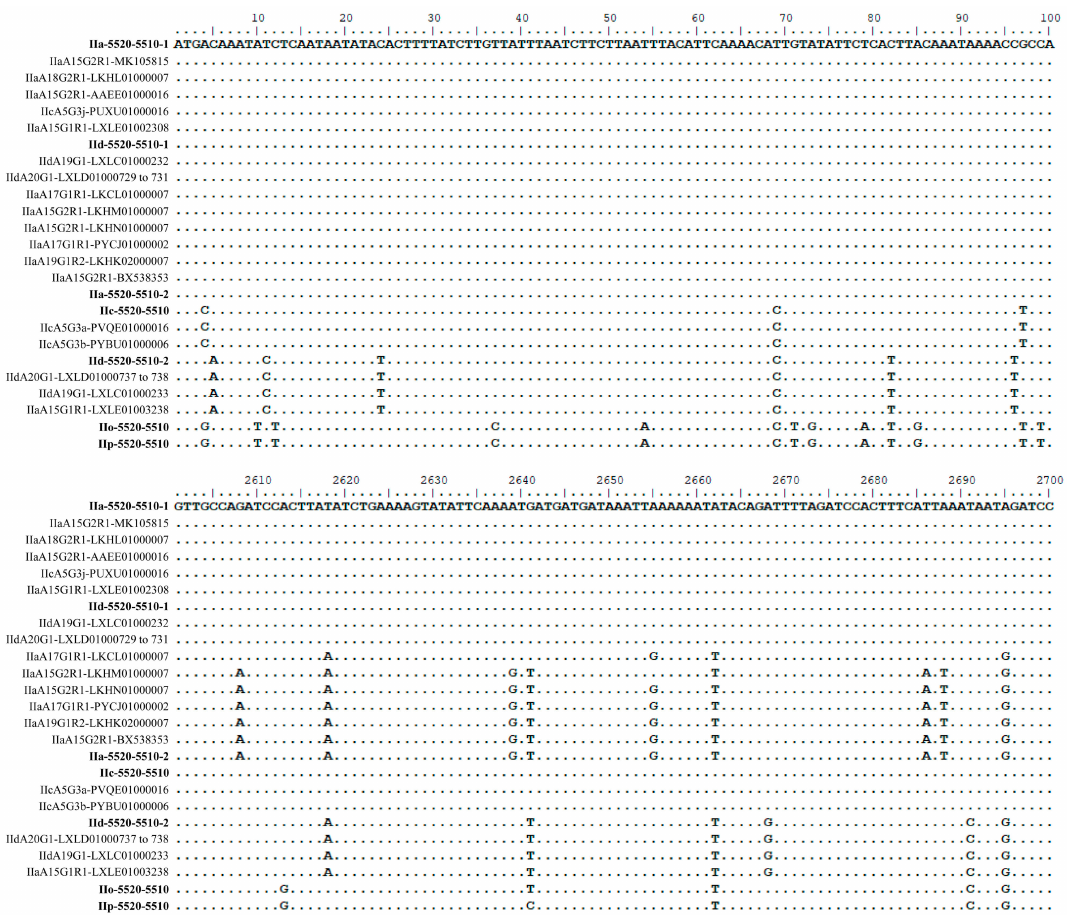
Figure 3. Alignment of unique nucleotide sequences of the cgd6_5520-5510 gene obtained in this study together with 18 other cgd6_5520-5510 sequences. Seven representative sequences of the cgd6_5520-5510 gene obtained in this study are shown in bold. The remaining 18 sequences were downloaded from the GenBank database (Table 3). The nucleotides identical to the reference sequence (the first line of the alignment) are shown as dots. Some of the sequences, which are identical in the first 2607 bp, have a sequence similarity to others in the last 777 bp, leading to a mosaic sequence pattern at the 3 (cid:48) end of the